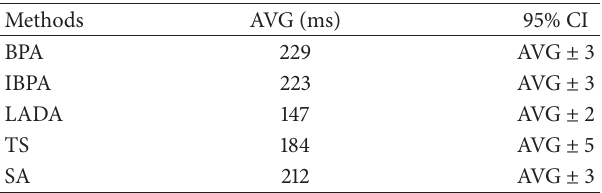
Table 4: The average execution times, in milliseconds, and the 95% Confidence Interval values for each heuristic